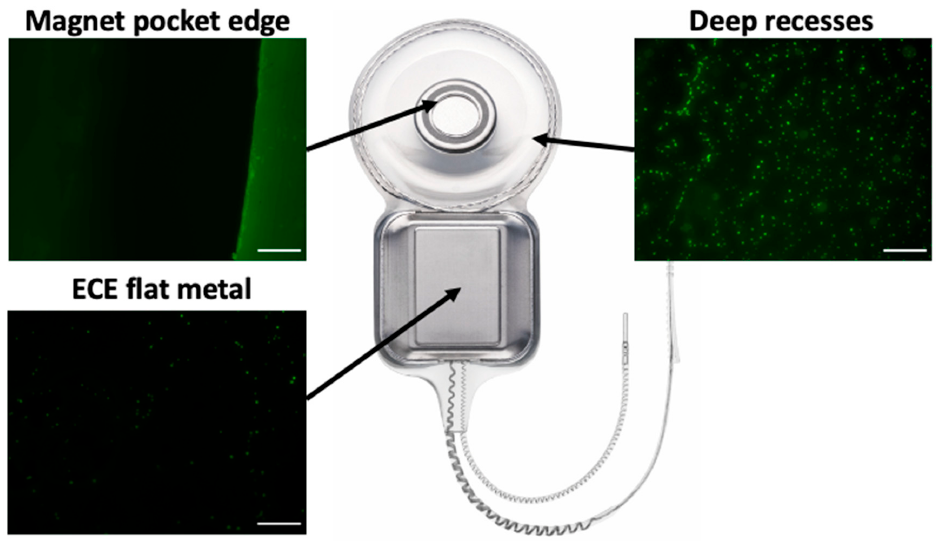
Figure 2. Bacterial attachment is decreased on CI500/Profile series cochlear devices. Attachment of S. aureus to prototype CI500/Profile series devices in in vitro assays visualized with Syto-9 (green) stain. Imaged regions were the magnet pocket edge, deep recesses or extracochlear electrode (ECE) flat metal. All regions showed very little bacterial attachment and no bacterial aggregates were observed. Images of CI24RE devices imaged at the same time as these CI500/Profile images were identical to those shown in Figure 1A. Scale bar is 100 μ m. Images are representative of four devices.